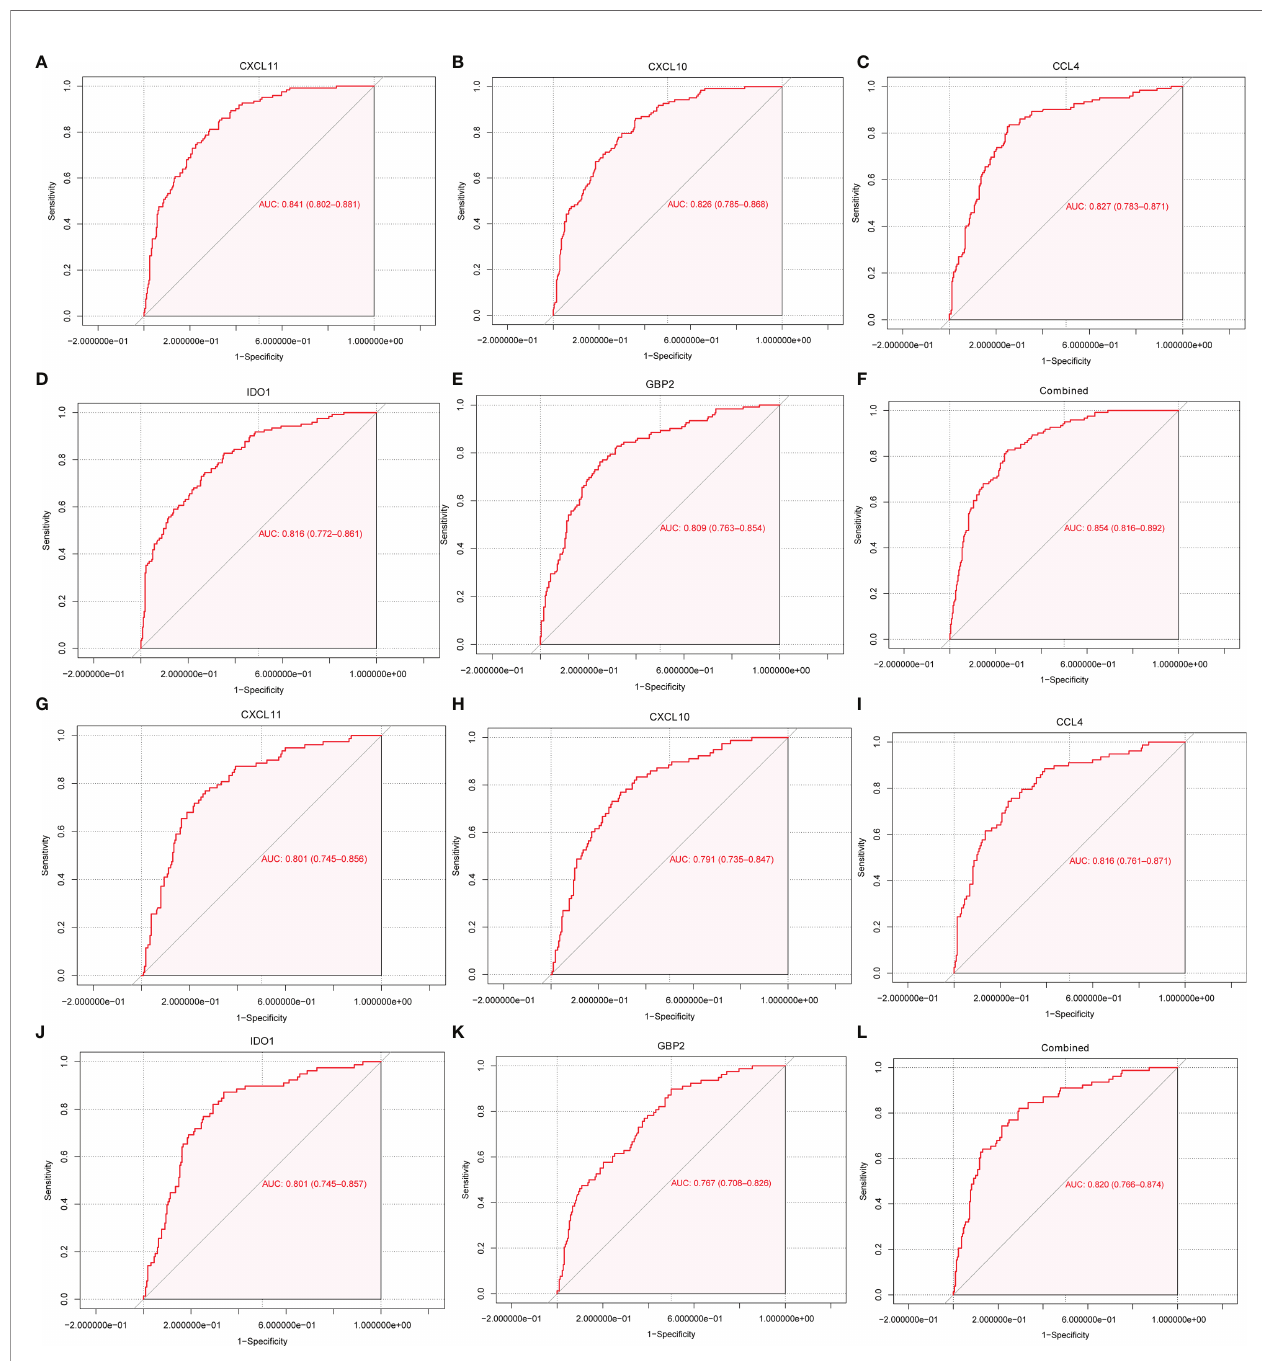
FIGURE 5 | ROC curve for discriminating rejection from no-rejection tissues. (A – F) ROC curve of CXCL11, CCL4, CXCL10, IDO1, GBP2 and after fi tting to one variable in the discovery cohort. (G – L) ROC curve of CXCL11, CCL4, CXCL10, IDO1, GBP2 and after fi tting to one variable in the GSE48581